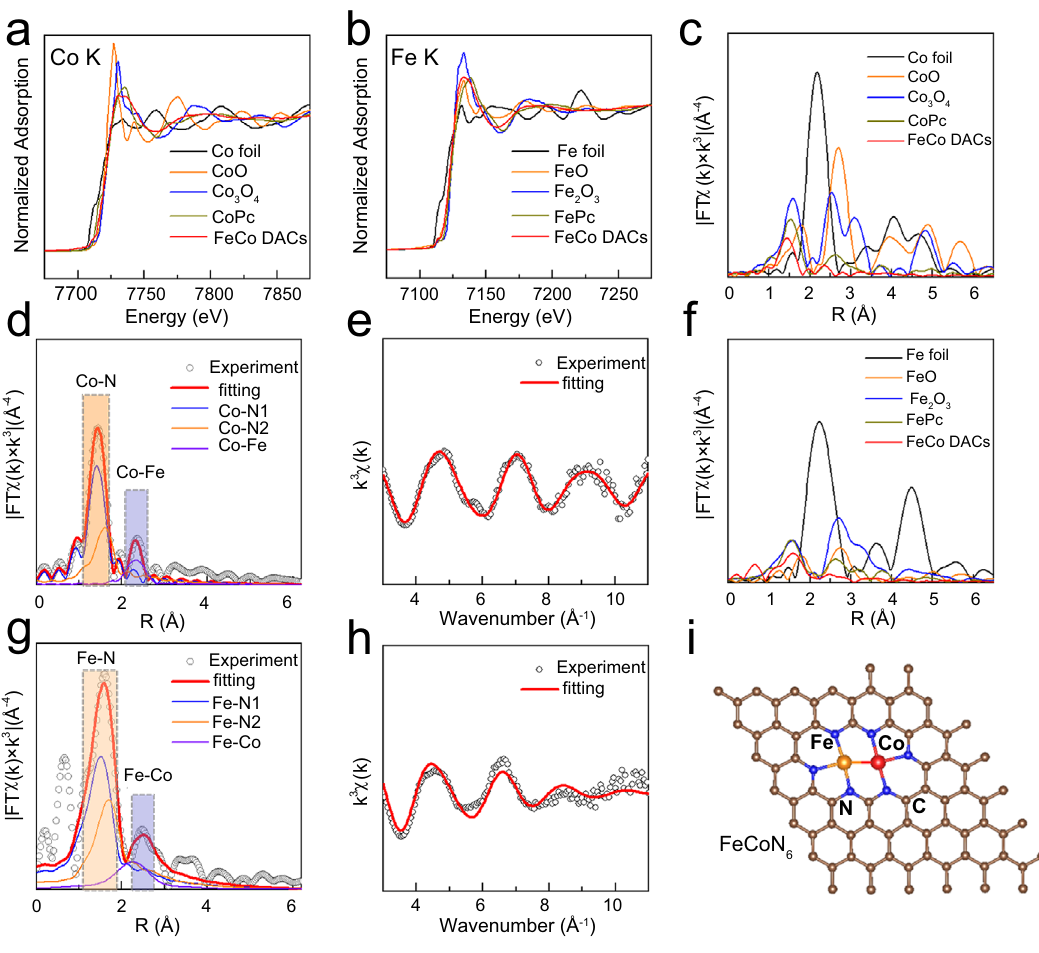
Fig. 3 | XAS characterizations of the Fe-Co DACs. a , b Fe and Co K-edge XANES spectra. c Fouriertransformation(FT)-EXAFSspectraofCo. d EXAFS fi ttingcurveof Co in Fe-Co DACs. e K-edgek-spaceexperimental EXAFS spectraand fi tting curves